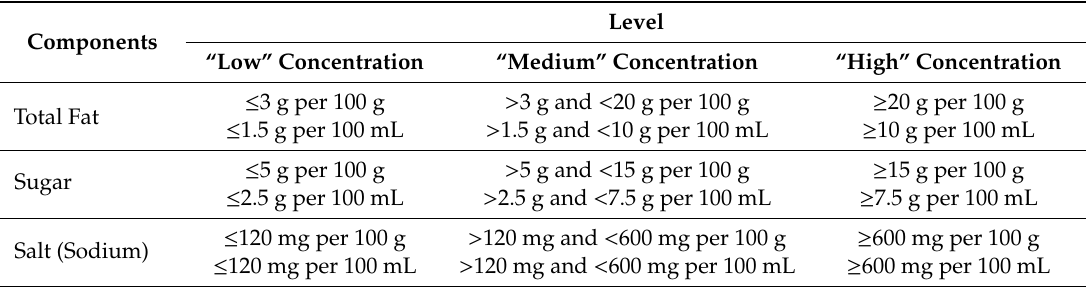
Table 1. Components and permitted